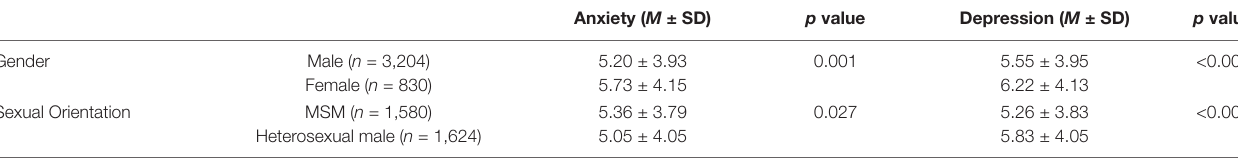
TABLE 1 | Scores of the HADS across patient